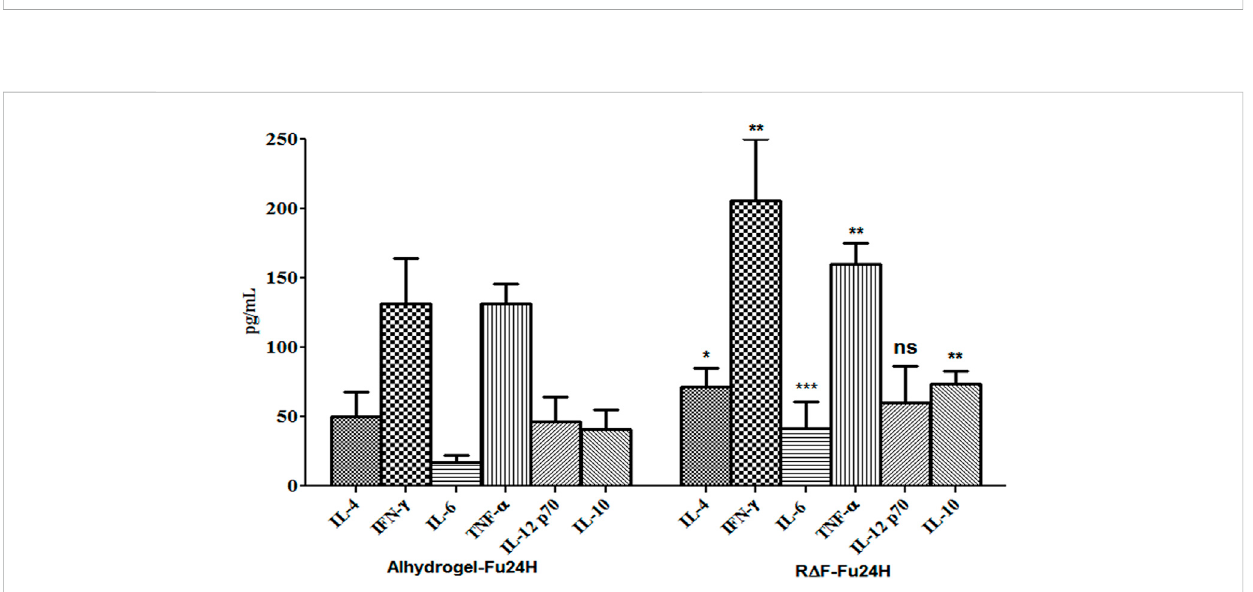
FIGURE 6 Cytokine response elicited by Fu24H delivered using R Δ F NPs and Alhydrogel ® . The amount of IL-4, IL-10, IFN- γ , TNF- ɑ , IL 6, and IL-12p70 elicited byFu24HwasmeasuredusingELISA.Errorbarsrepresentmean±standarddeviation; n =6mice/group;Statisticallysigni fi cant(Student ’ st-test; p < 0.01) data